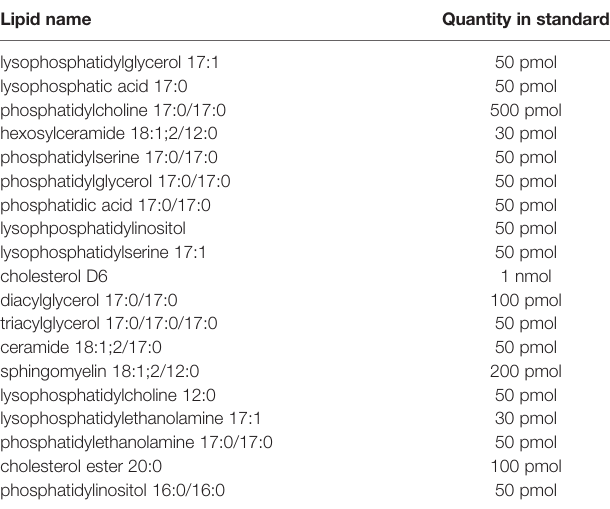
TABLE 4 | Composition of standards used for analysis of plasma